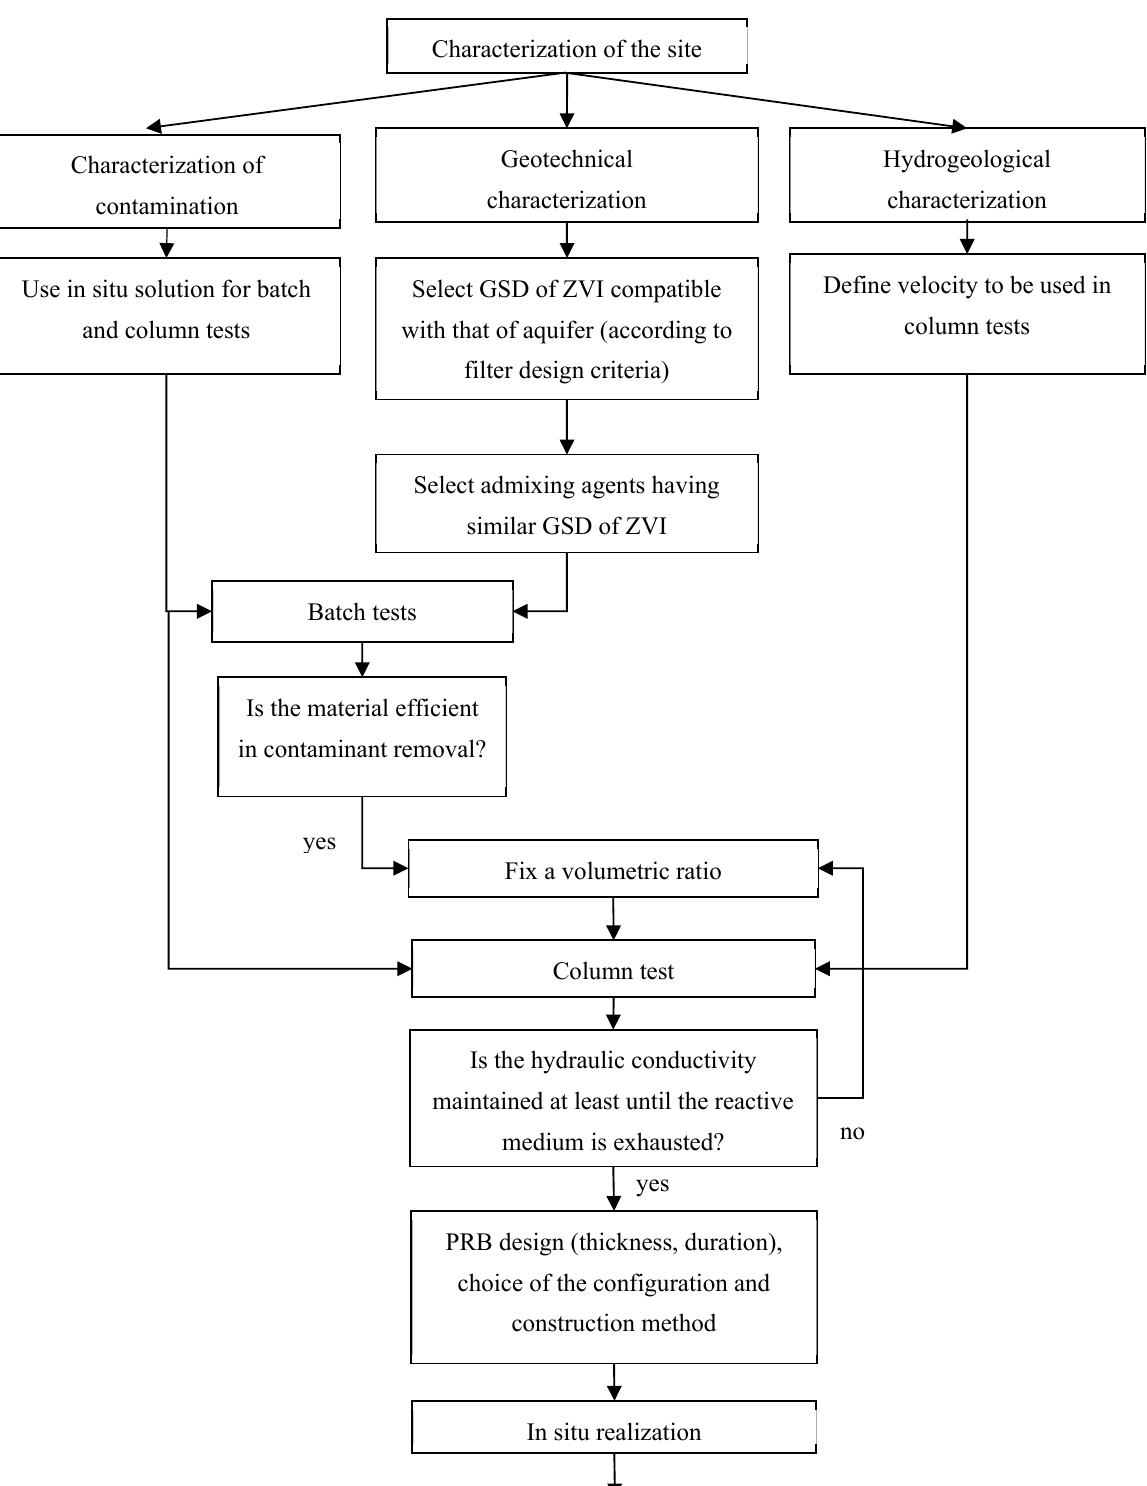
Figure 9. A flowchart of the design of hydraulically efficient ZVI-based PRBs.